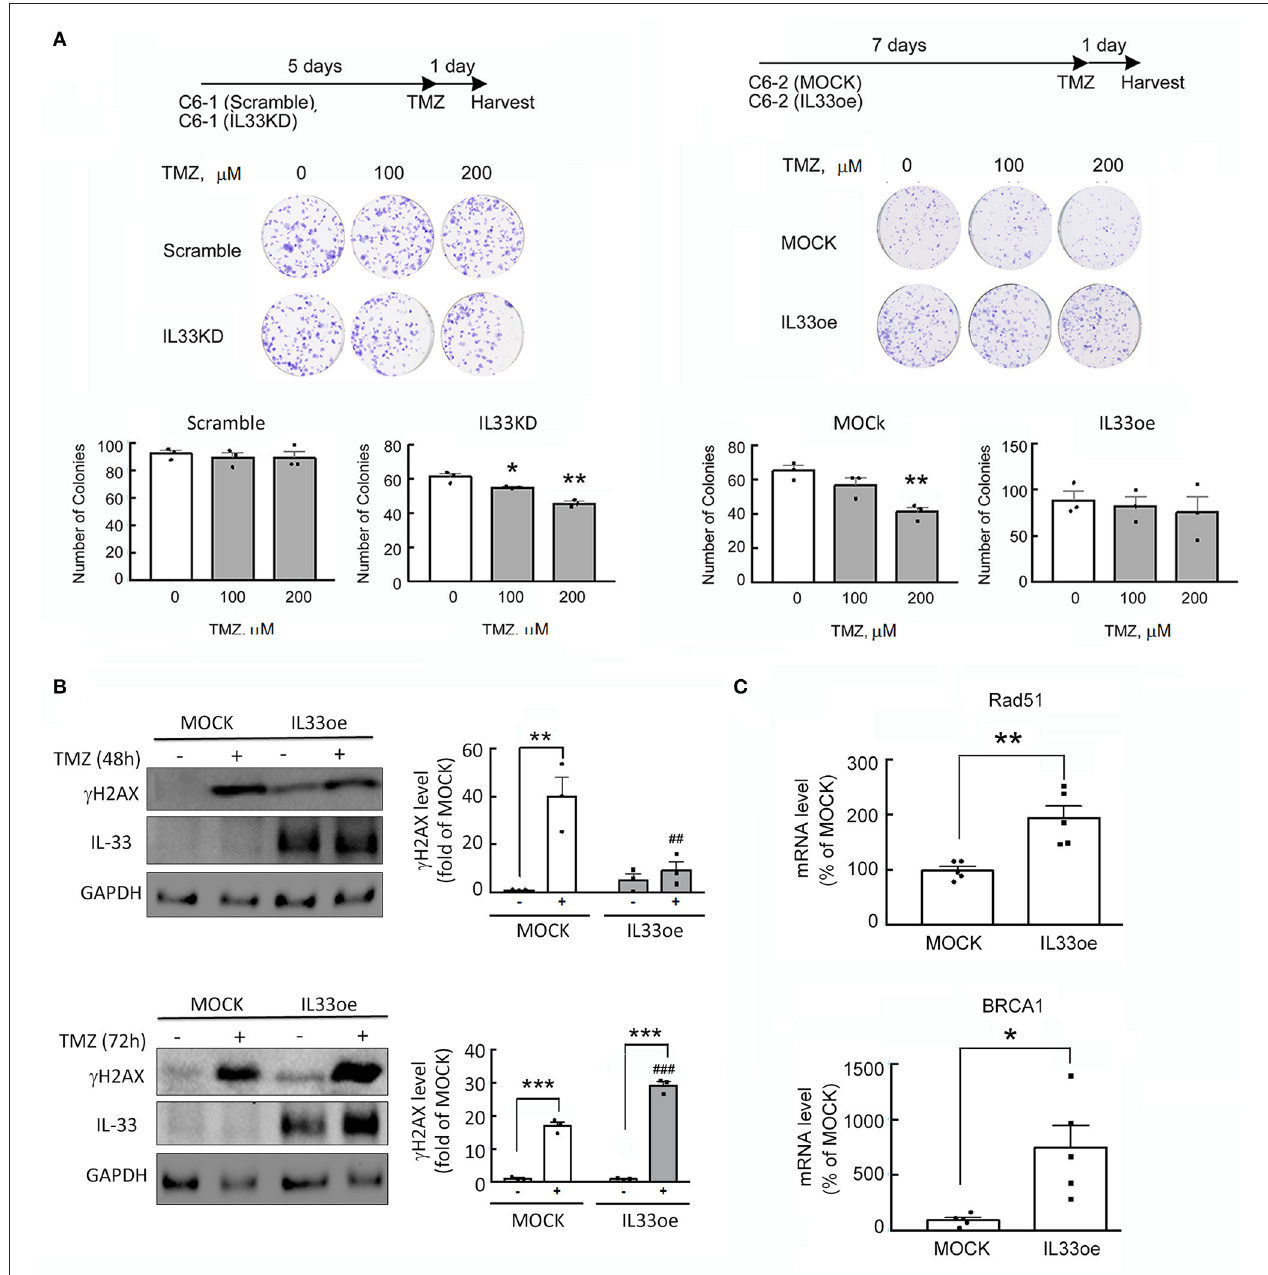
FIGURE 2 | IL-33 protects glioma cells from the insult of DNA damaging drug, TMZ. (A) Scramble- and IL33KD-C6 cells were seeded onto a 6-well plate at the amount of 200 cells per well, and then grown in 10% serum containing medium for 5 days. The cultures were exposed to TMZ (0, 100, and 200 µ M) for another day. Alternatively, MOCK- and IL33oe-C6 cells were maintained in 10% serum containing medium for 7 days, and treated with TMZ (0, 100, and 200 µ M) for another day. The colonies were quantified using NIH Imaging J. Data are shown as mean ± SEM from the three cell passages ( n = 3). * P < 0.05, ** P < 0.01 vs. Vehicle. (B) MOCK- and IL33oe-C6 cells were treated without or with TMZ at 200 µ M for 48 and 72h. Total proteins collected from the cultures were subjected to Western Blot assay to examine the levels of γ H2AX, IL-33, and GAPDH. The γ H2AX protein levels in each immunoblot were normalized by the level of GAPDH (a loading control). The results are presented as mean ± SEM from three cell passages ( n = 3). ** P < 0.01, *** P < 0.001 vs. the relative control culture; ## P < 0.01, ### P < 0.001 vs. MOCK. (C) The expression of Rad51 and BRCA1 mRNA in MOCK- and IL33oe-C6 were measured by qPCR analysis. The results are presented as mean ± SEM from the five cell passages ( n = 5). * P < 0.05, ** P < 0.01 vs. MOCK. TMZ, temozolomide; qPCR, quantitative PCR.